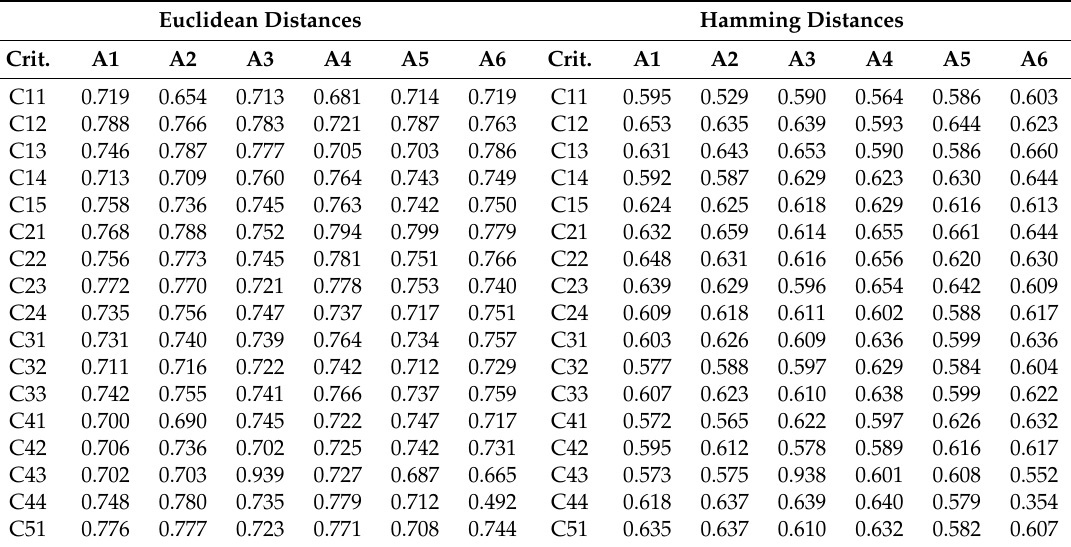
Table 8. LNN-weighted Euclidean and Hamming distances.